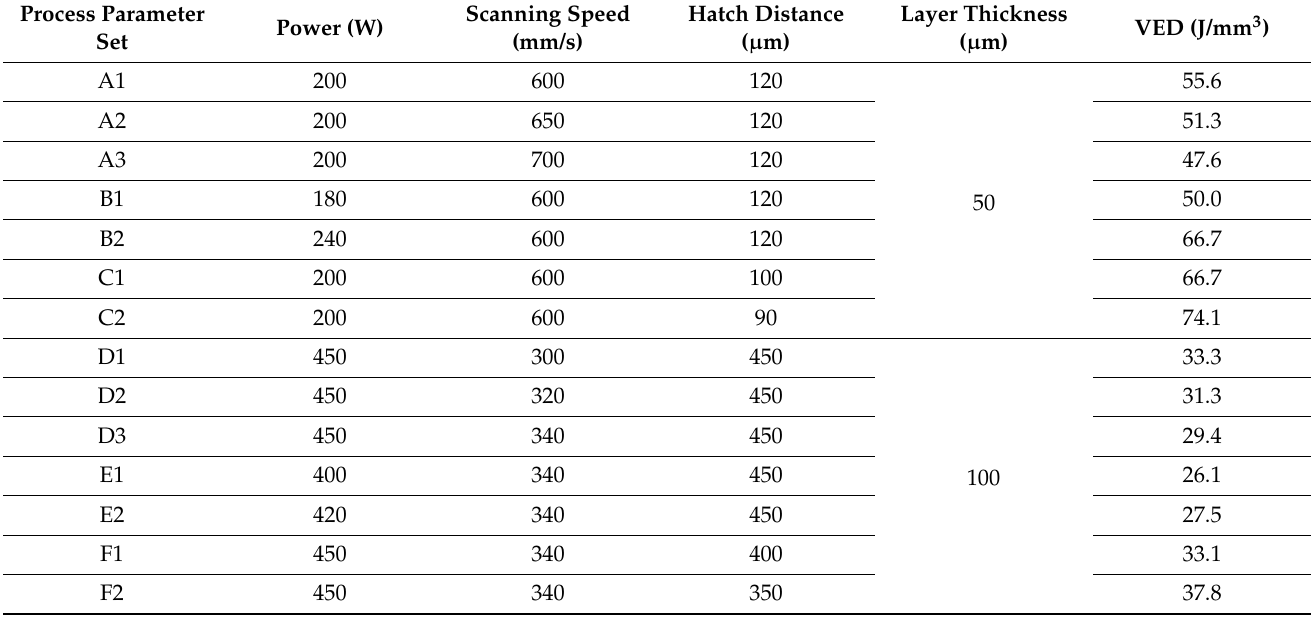
Table 1. SLM process parameters used to fabricate the samples.